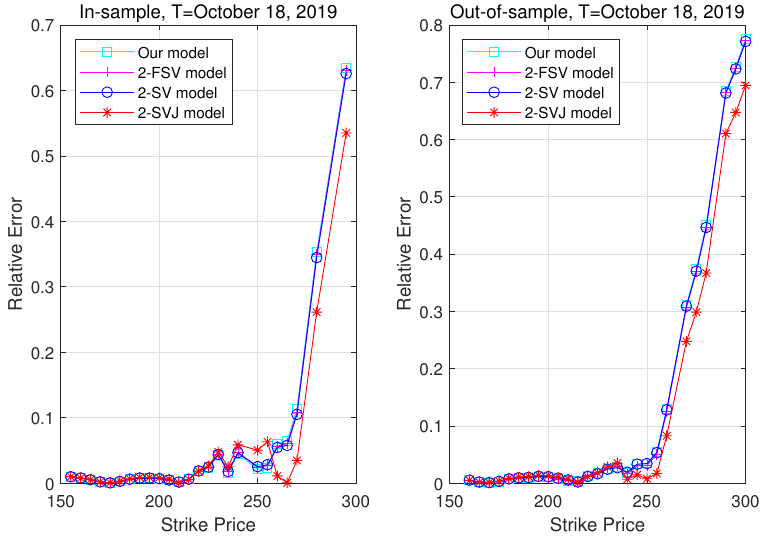
Figure 9. The comparison of predicted prices of four model specifications and market prices on 9 May 2019, with maturity T = 18 October